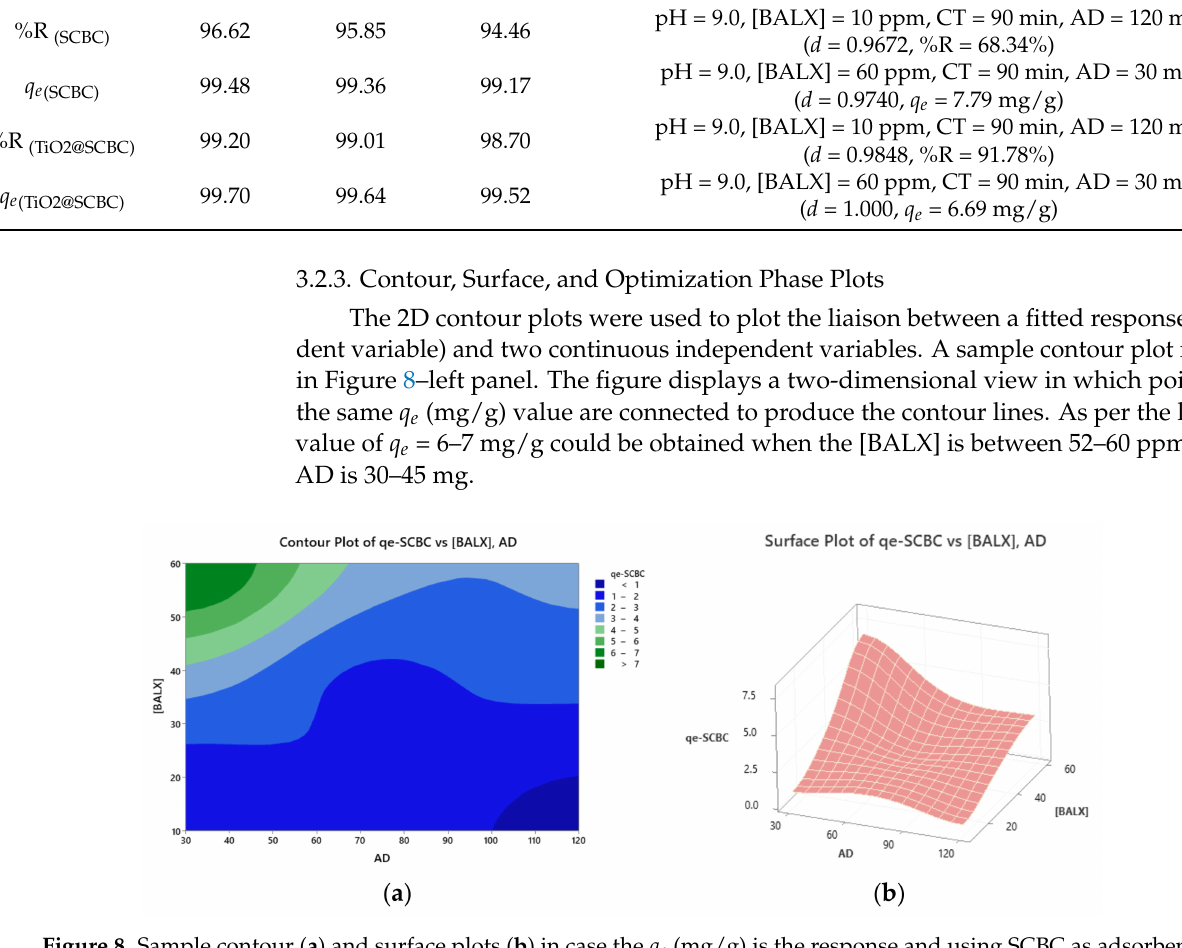
Figure 8. Sample contour ( a ) and surface plots ( b ) in case the q e (mg/g) is the response and using SCBC as